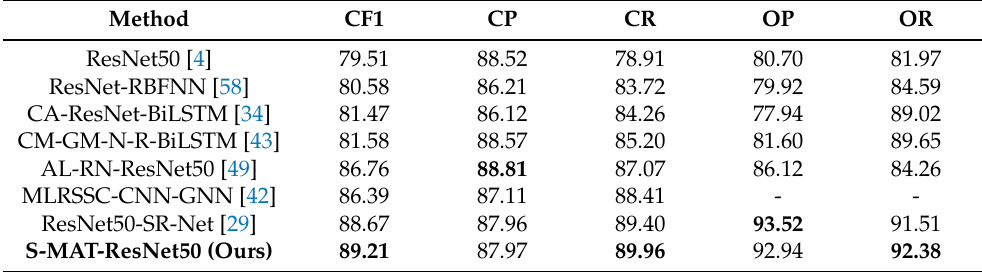
Table 1. Comparisons of our method with previous state-of-the-art methods on the UC-Merced Multi-label dataset. Among all the metrics, CF1 is the primary metric. The bold means the best performance. All metrics are in